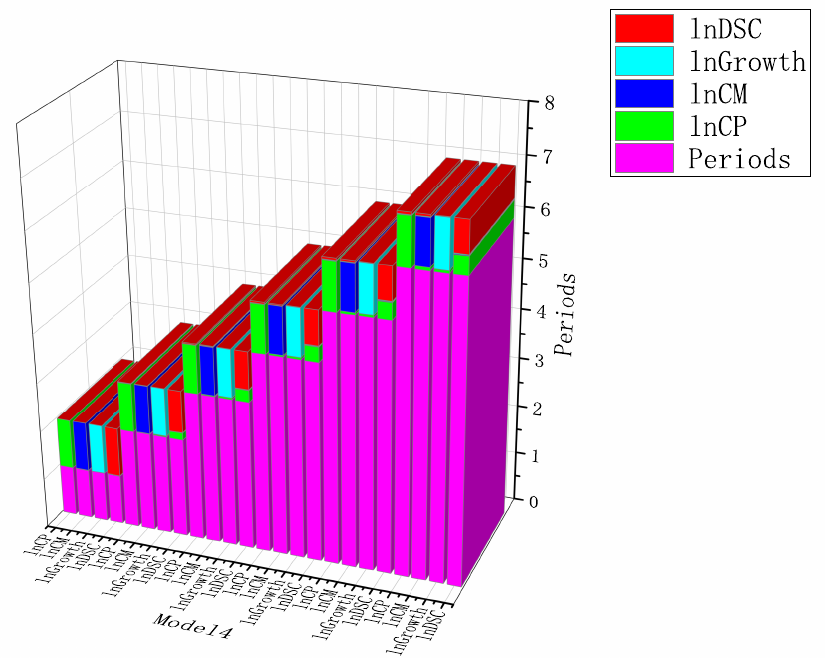
Figure 15. The graph shows the results of the variance decomposition of Model 4. The horizontal axis indicates the different variables including debt servicing capacity (lnDSC) (in red), growth capacity (lnGrowth) (in light blue), corporate management (lnCM) (in blue), and corporate performance (lnCP) (in light green), the vertical axis indicates the contribution of each variable at different lags (see Appendix A for specific figures), and the magenta area indicates the number of periods